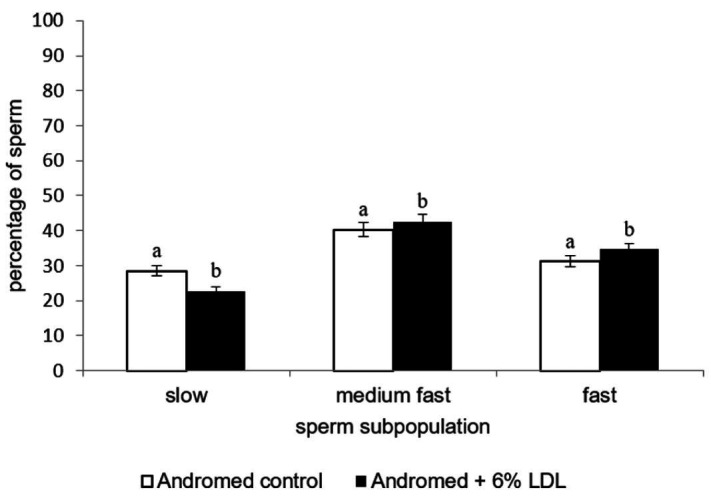
Effect of LDL addition to the Andromed extender on sperm distribution in clusters after thawing. Different superscripts in same cluster represent significant differences (P < 0.05).